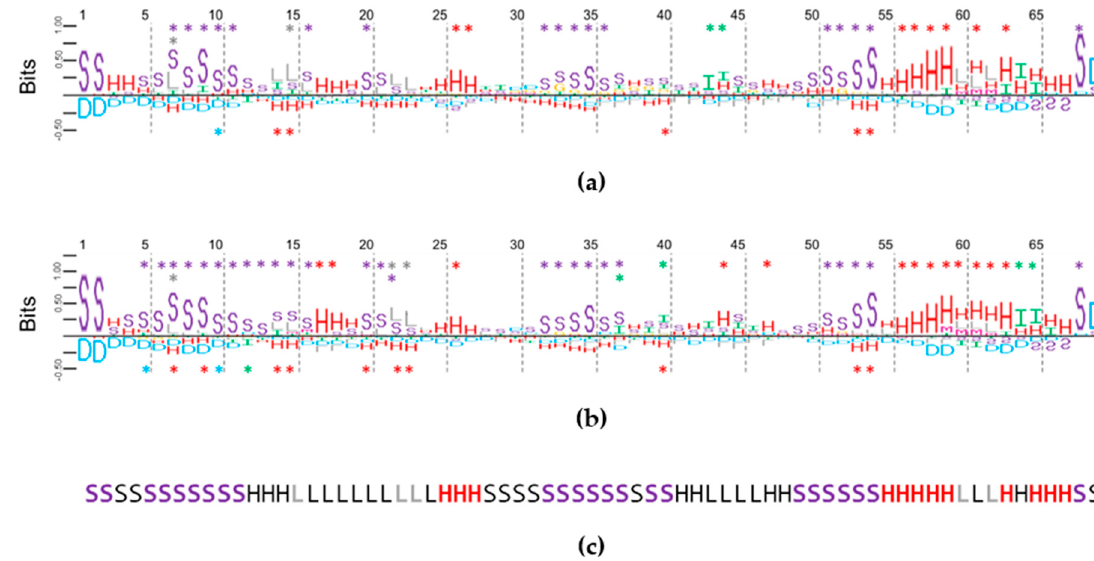
Figure 3. Position specific score matrix (PSSM) of SSE for ( a ) dominant-only and ( b ) dominant + suboptimal structures of aptamers using the random sequence population as the background and α = 1 in the additive smoothing function. A higher bit score either positive (i.e., stronger presence) or negative (i.e., stronger absence) for one or more SSE at a particular numerical base position corresponds to a greater height of the one-letter symbol for a given SSE. Numerical base positions with significant di ff erences in a given SSE determined separately using a one-tailed two proportion Z-test (shown in Figures S4 and S5, respectively, in supplementary materials) are marked with an asterisk. ( c ) secondary structure strings (SS$) for aptamer 201.S1 with highest scoring match to both PSSM shown above. Individual position-specific matches in SSE between PSSM and 201.S1 SS$ are color-matched while nonmatching SSE are shown in black text in ( c ).